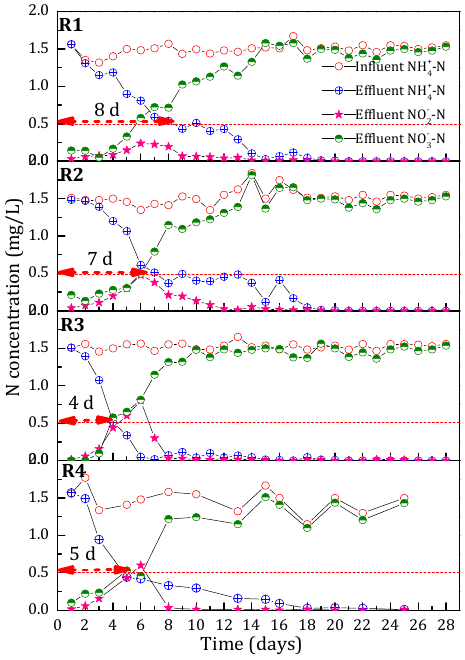
Figure 2. The effect of influent Fe 2+ concentration on the variation of N (NH 4+ -N, NO 3 − -N and NO 2 − -N) concentration during the start-up period.